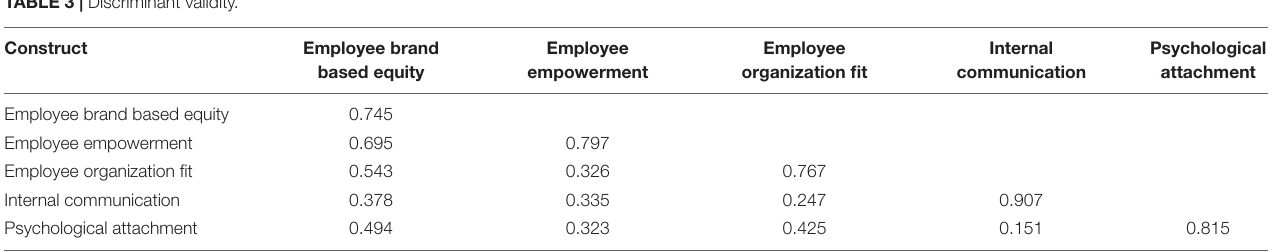
TABLE 3 | Discriminant validity.